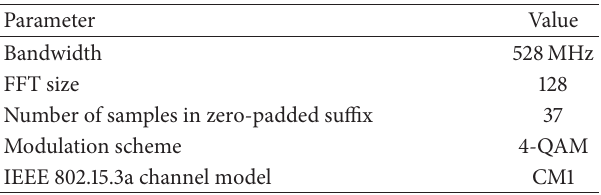
Table 2: Simulation